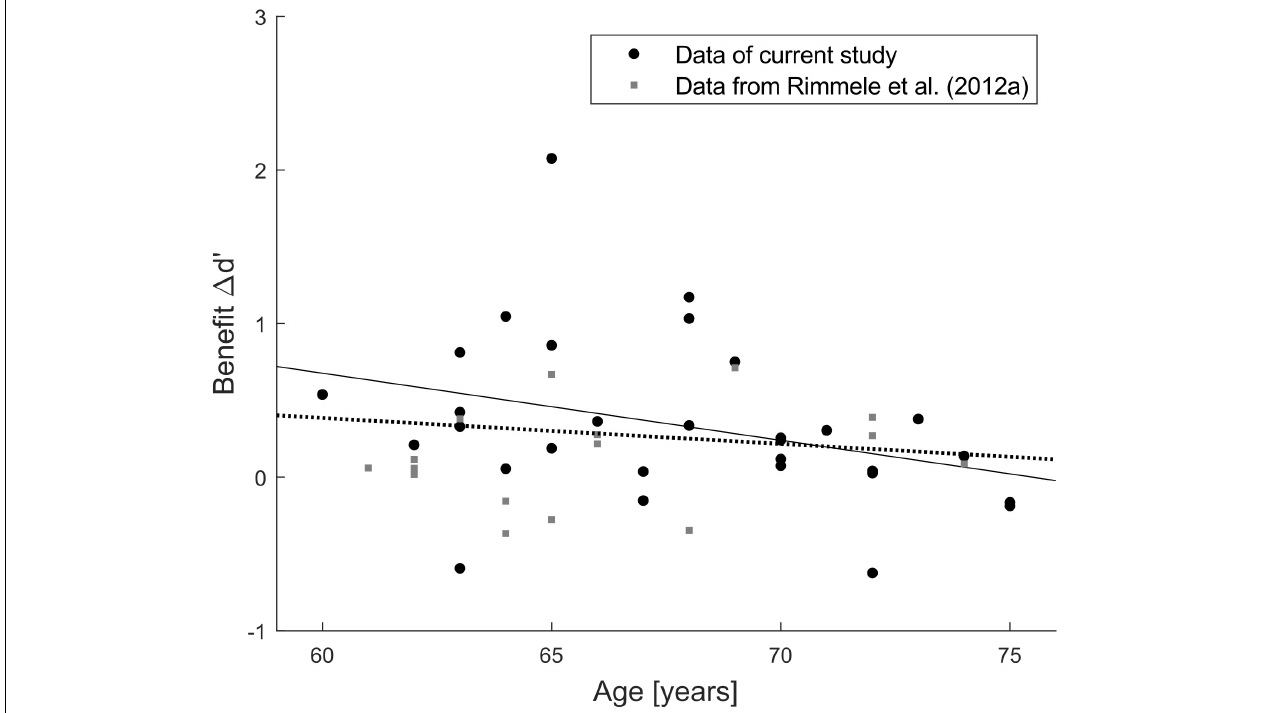
FIGURE 6 | Post hoc joint analysis of two independent participant samples. Scatterplot of the relation between age and benefit (cid:49) d’ for performance in the predictable/isochronous minus random condition. Each dot refers to one individual data point (black dots: current study, gray squares: Exp. 2 in Rimmele et al., 2012a). Solid line indicates correlation in the current study ( r = –0.33, p = 0.07, N = 30), dotted line indicates correlation in the combined data ( r = –0.14, p = 0.34, N =